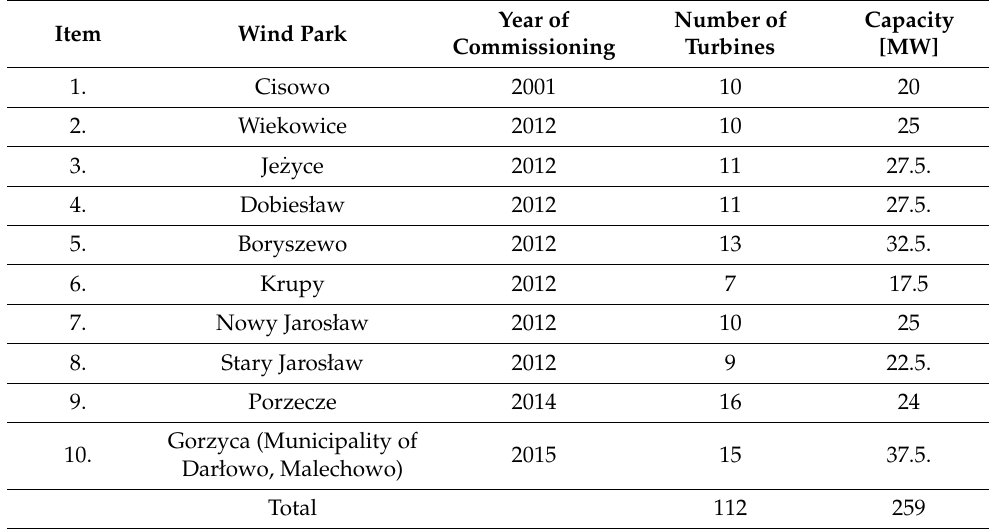
Table 2. Wind Parks in the Municipality of Darłowo managed by the Wind Service Company [78].